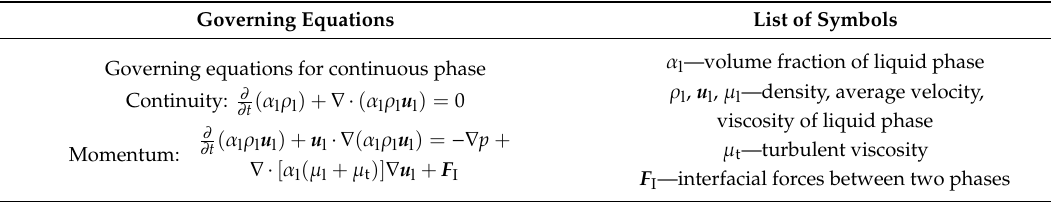
Table 1. Governing equations for the